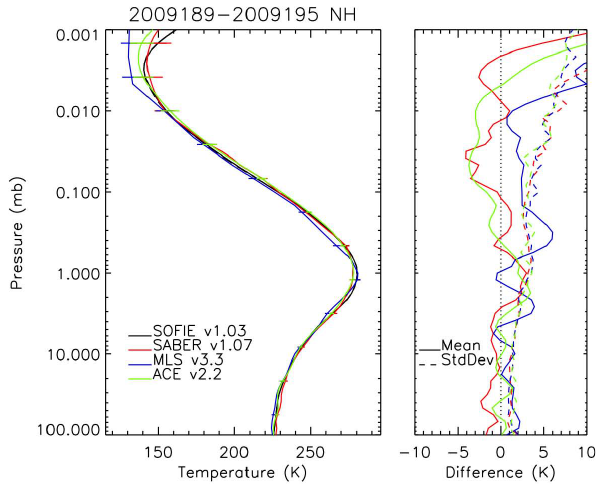
Fig. 31. Comparison between mean SOFIE (black), SABER (red), ACE (green), and MLS (blue) profiles for coincident Northern Hemisphere (NH) data for the period 20–26 February 2009, left- hand panel shows the mean profiles, right-hand panel shows the mean difference and difference standard deviation profiles (SOFIE – each of the